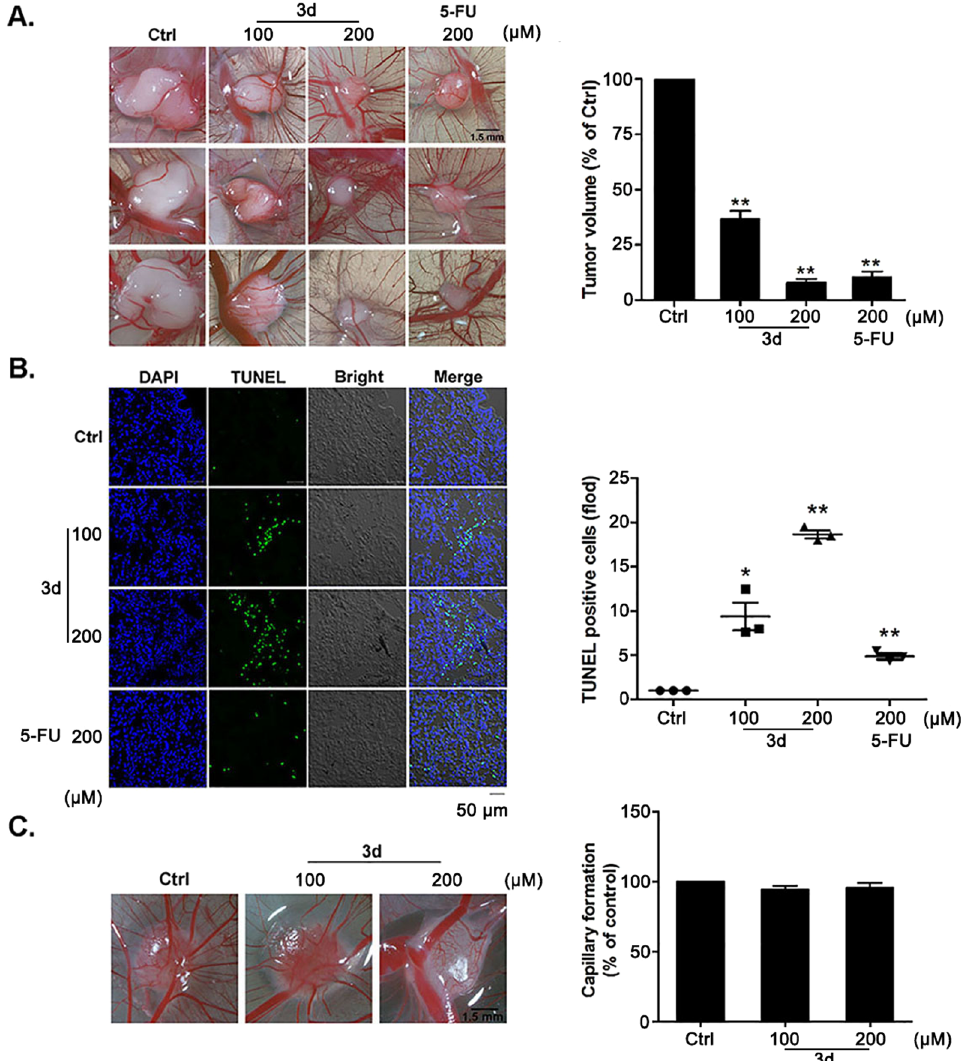
Figure 7. Effects of 3d on the tumor xenograft growth and normal CAM angiogenesis in vivo . Images of control and treated tumors photographed by biomicroscopy ( A ). Tumor volume was quantified. The volume of 3d -treated tumor is smaller than control group. Bar, 1.5 mm, N = 5. TUNEL staining analysis of the frozen sections of tumors treated differently, and apoptotic rate was quantified ( B ). 3d (100 μ M, 200 μ M) induced tumors’ aponptosis most obviously compared to the treatment of control (0.1% DMSO) and 5-FU (200 μ M). Bar, 5 μ m, N = 5. Angiogenesis on gelatin sponge with the treatment of 3d or DMSO (control) photographed by biomicroscopy and quantified ( C ). The results showed that 3d did not affect capillary formation. Bar, 1.5 mm, N = 5. Data are mean ± SEM ( * p < 0.05, ** p < 0.01 vs control. N =